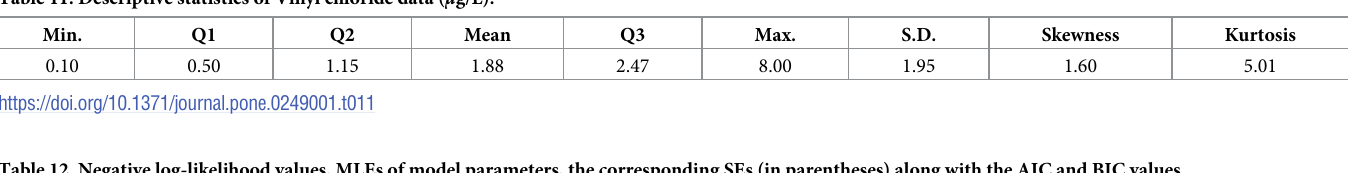
Table 12. Negative log-likelihood values, MLEs of model parameters, the corresponding SEs (in parentheses) along with the AIC and BIC values. Model